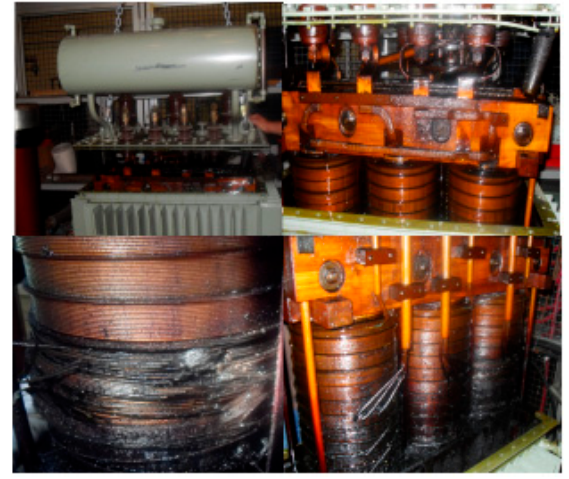
Figure 11. FRA measurement between HV ‐ LV windings for a faulty transformer [21].